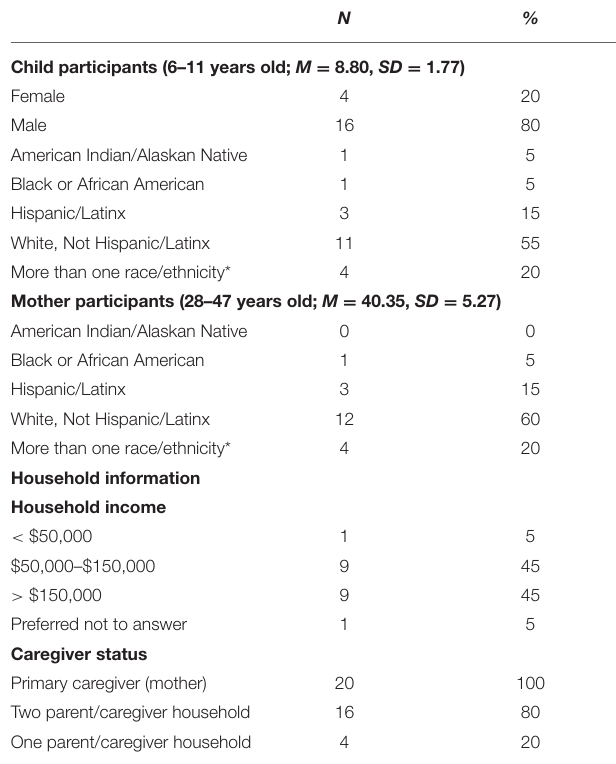
TABLE 1 | Study participant and household